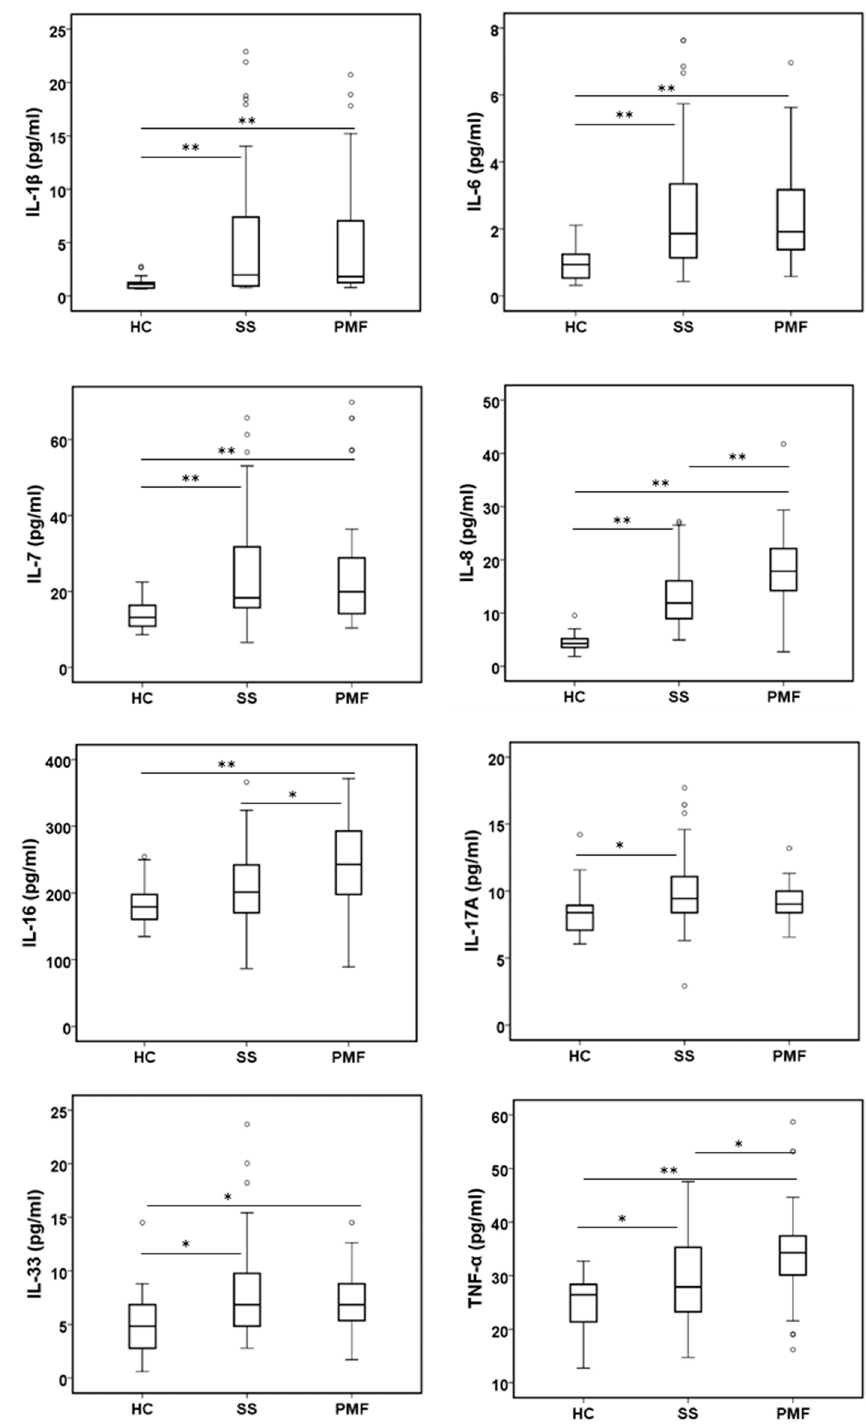
Figure 1. Levels of inflammatory cytokines in plasma from peripheral blood were assayed in patients diagnosed with simple silicosis (SS), progressive massive fibrosis (PMF) and healthy controls (HC). All cytokines were assayed by the Bio-Plex assay, except IL-16 and IL-33, which were assayed by R&D Systems Assay. * and ** indicate significance p < 0.05 and p < 0.01, respectively.